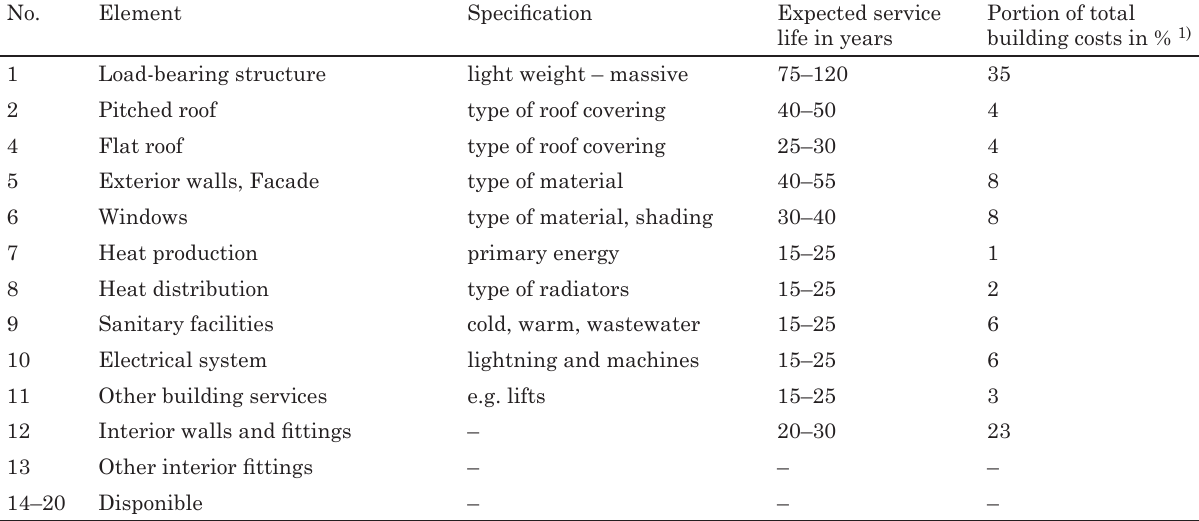
Table of building elements used in the practical software application of the method Schroeder (Stratus/ Spectus)